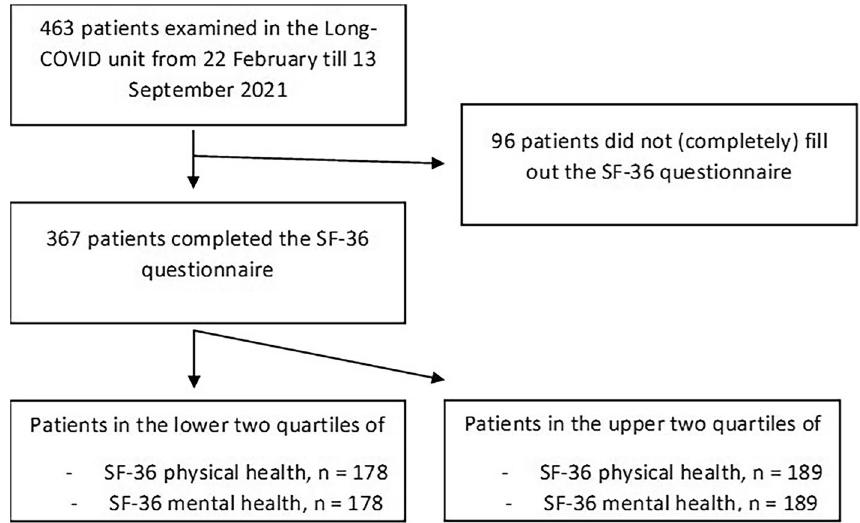
Figure 1. Patient enrolment. Shown is the full study population and the patients who had to be excluded due to missing SF-36 questionnaire. The resulting collective was dichotomized by the median of the physical component summary (median 70.6) and the mental component summary (median 69.1),